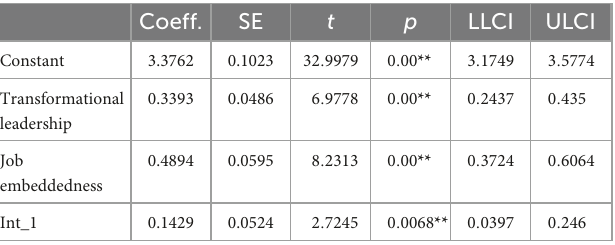
TABLE 9 The interaction between transformational leadership and job embedding.